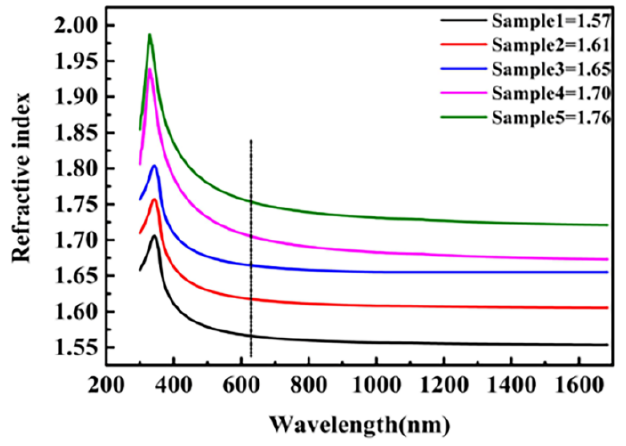
Figure 10. Refractive index of coating with different silicon and titanium content (Note: the content ratio of sample 1–5 is 1:1, 1:2, 1:3, 1:5, 0:1).